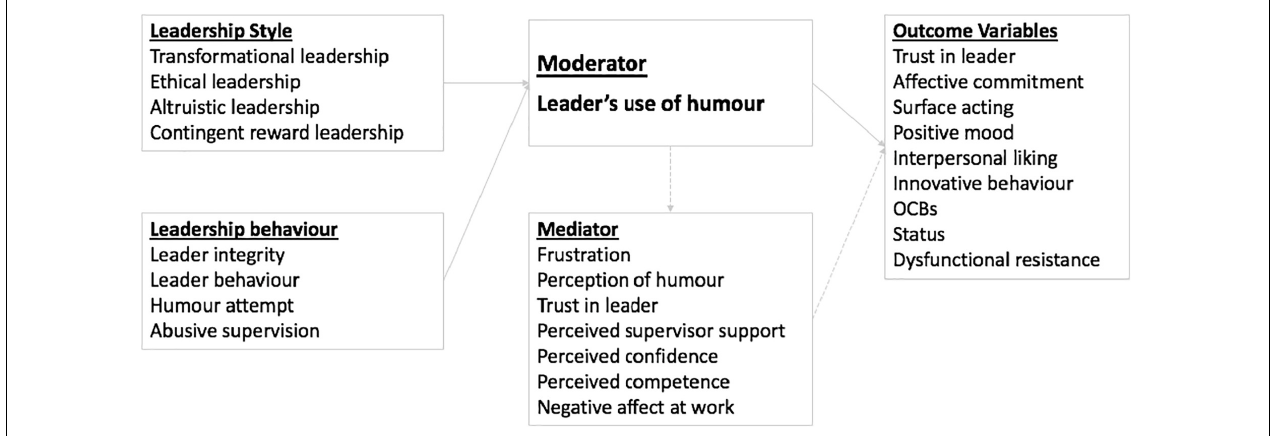
FIGURE 5 | An illustrated summary of the studies that investigated interactions between leadership style, behavior and leaders’ use of humor, and their potential outcomes (directly or indirectly) via mediating